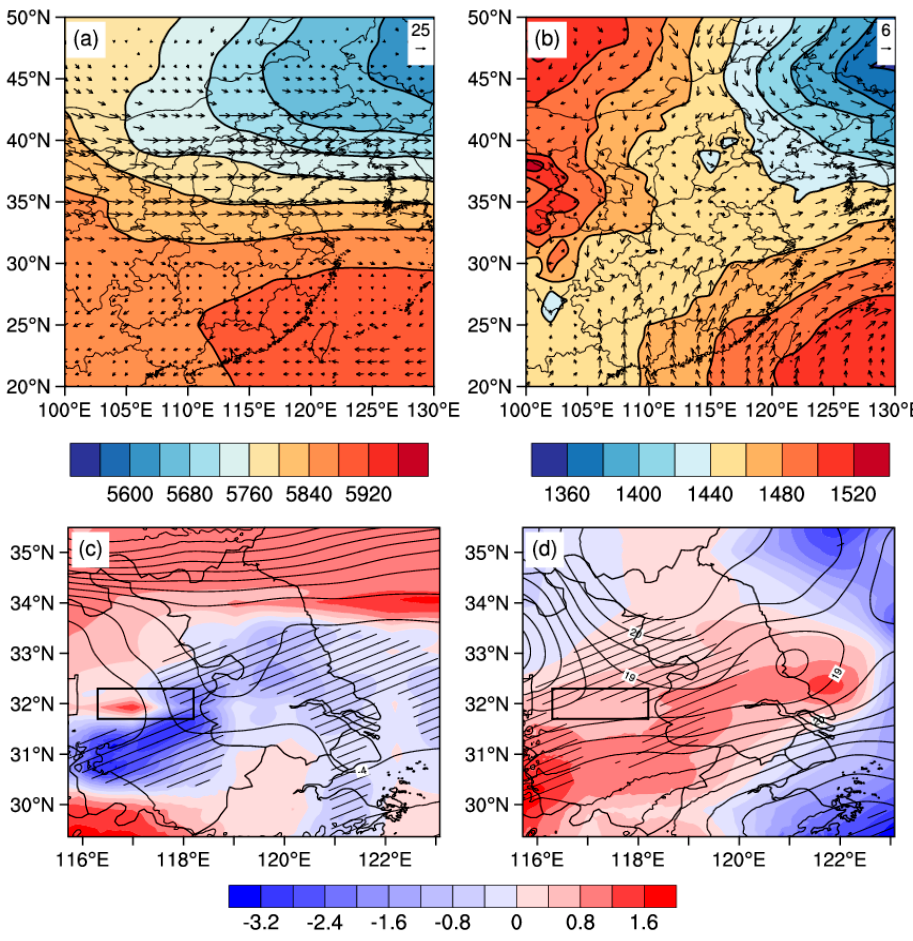
Figure 3. 12 July 2014, 0000 UTC results. ( a ) 500-hPa geopotential height (shaded and contoured, unit: dagpm) and 200-hPa wind (vectors, unit: m/s), ( b ) 850-hPa geopotential height and wind, ( c ) sensitivity of forecast variable R with respect to the 500-hPa temperature (shaded, unit: °C; the dashed area indicates that the sensitivity passed a 0.05-level significance test) and 500-hPa temperature (contoured, unit: °C), and ( d ) sensitivity of forecast variable R with respect to the 850-hPa temperature and 850-hPa temperature. The black box indicates the response region.